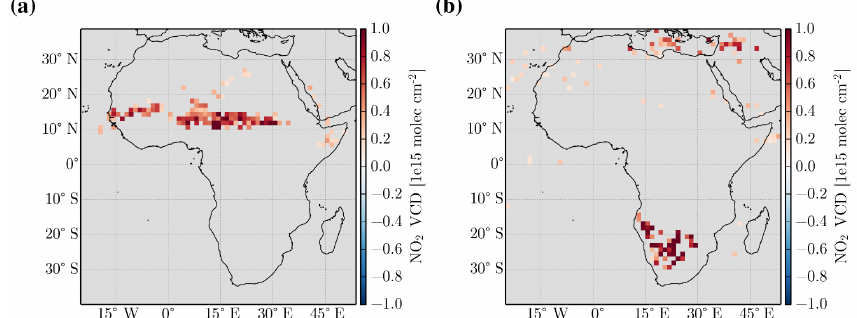
− 2 ) on Day0 compared to the background level for April–May– Figure 4. (a) Significant OMI NO 2 VCD enhancements (in 1 × 10 15 moleccm June (2007–2010), which represents the start of the wet season after the dry period in the northern part of Africa. Extensive enhancements in NO 2 over the narrow band of the Sahel can be seen. (b) The same for September–October–November (2007–2010), whereby strong enhancements are found in south-western Africa. This time period reflects the transition time between the dry and wet season in this